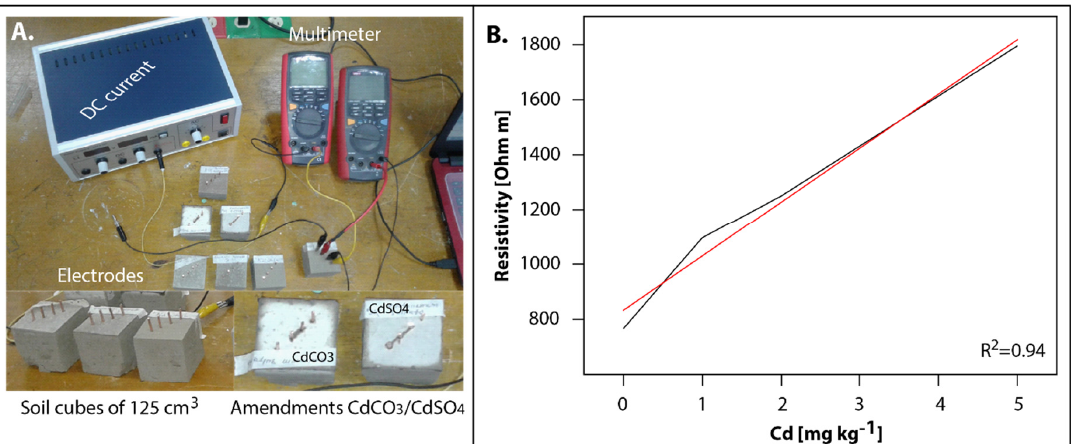
Figure 1. Calibration of the two-dimensional electrical resistivity tomography (2D-ERT) technique in vitro. ( A ) The equipment was set for two pure Cd reagents (CdCO 3 and CdSO 4 ), measured in four concentrations and in triplicate using a simple electronic device, consisting of the voltage current power, a multimeter, and electrodes; ( B ) the correlation between resistivities and Cd concentrations using cadmium sulphate (red line) and cadmium carbonate (black line). The correlation was high according to the coe ffi cient of determination, as shown in the plot. When no Cd was added the resistivity remained lower than 800 Ohm ·